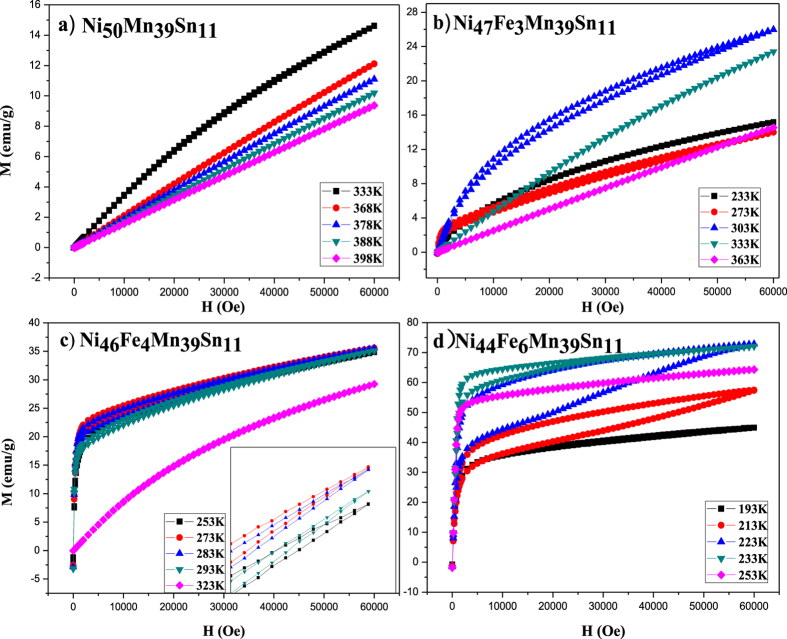
Magnetization curves of Ni50−xFexMn39Sn11 alloys at different temperatures (a) x = 0; (b) x = 3; (c) x = 4; (d) x = 6.